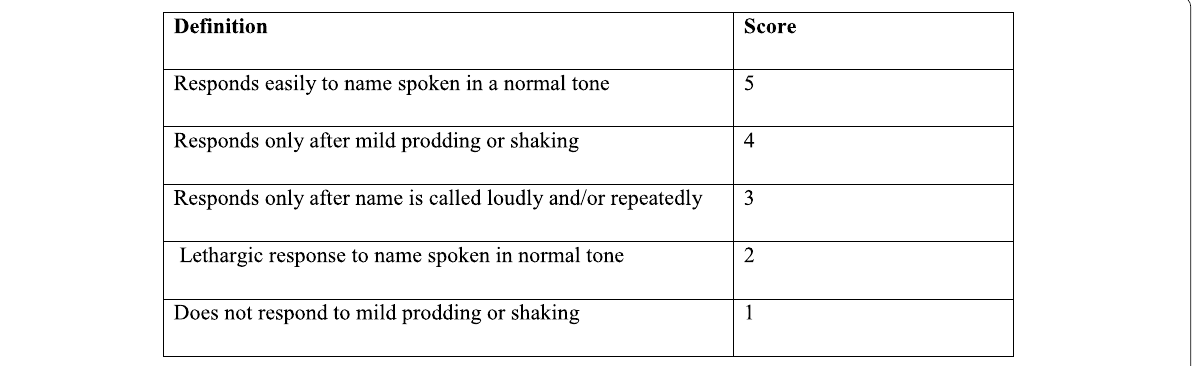
Fig. 3 Observer’s assessment of alertness/sedation score